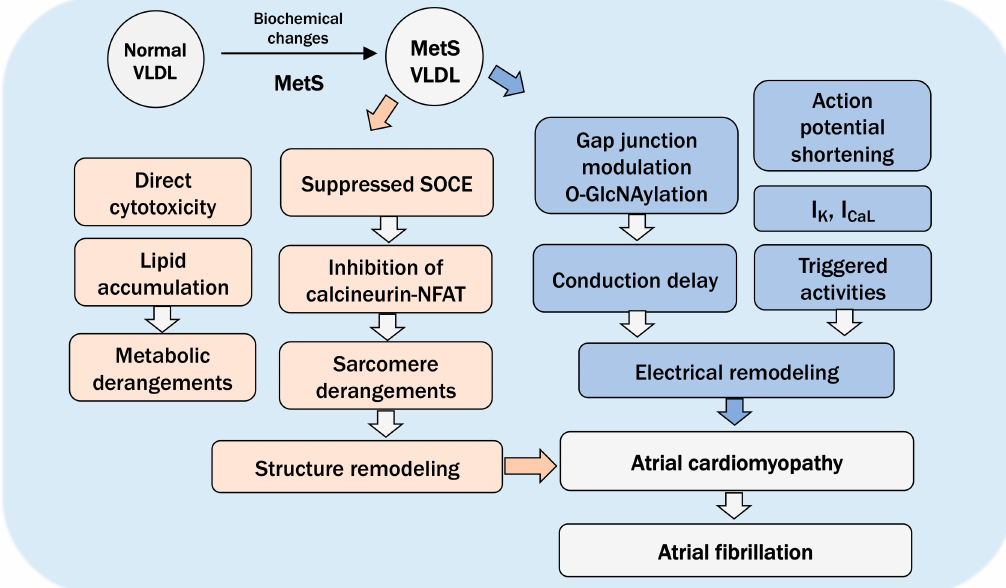
Figure2. ThepathogenicroleofVLDLinMetS-relatedatrialcardiomyopathy, exhibitedwithstructurally (in pink blocks) and electrical (in blue blocks) remodeling. The structural remodeling includes atrial dilatation, ventricular dilatation, and hypertrophy associated with impaired contractility, along with increased myocardial apoptosis, excessive lipid accumulation (consistent with EHRAS class IVf of atrial cardiomyopathy [10]), sarcomere disorders and myofilament derangements, and mitochondria morphological changes. The electrical remodeling includes shortening of action potentials, triggered activities, delayed intra-cardiac conduction [90], vulnerability to AF upon sympathetic stimulation, and unprovoked occurrence of AF. SOCE: store-operated calcium entry, NFAT: nuclear factor of activated T